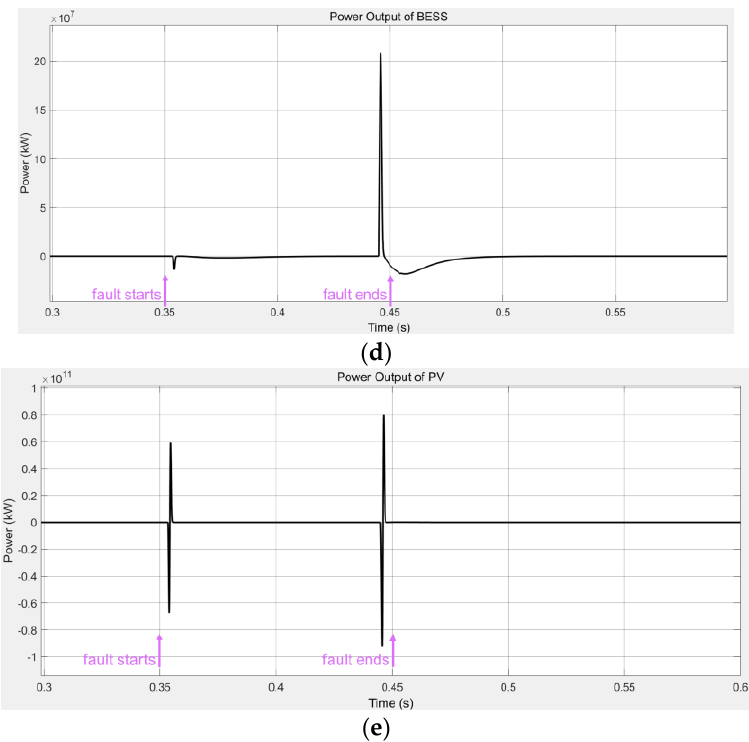
Figure 10. Performance when a phase-to-phase fault occurs on the AC side. ( a ) Signals at Bus 6; ( b ) Signals at AC/DC interfacing Bus 8; ( c ) Signals at DC bus; ( d ) Power output of the BESS; ( e ) Power output of the PV generation.